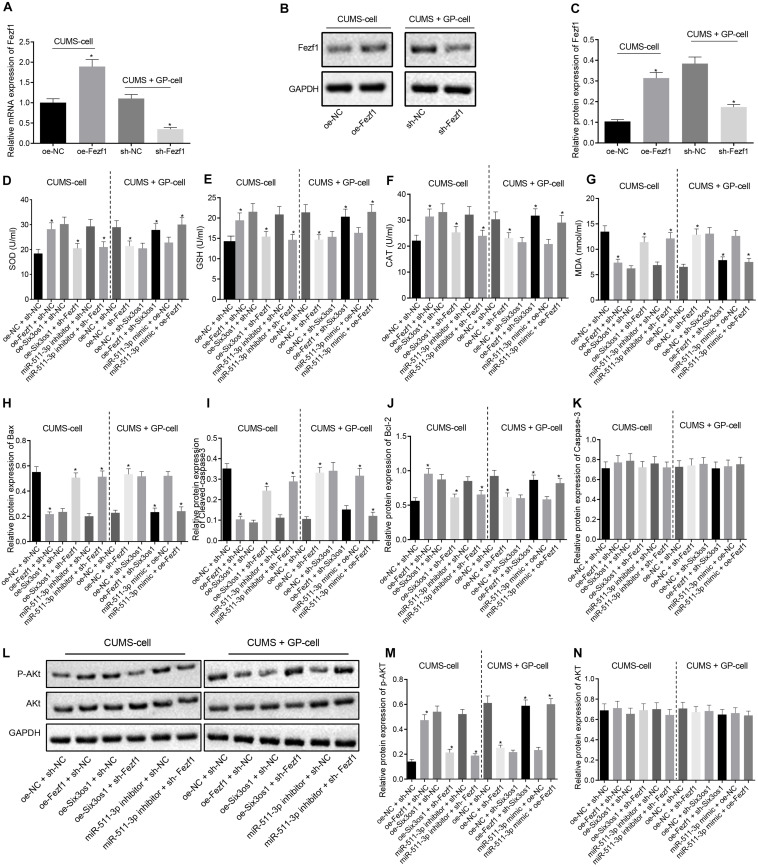
Six3os1 activates the Fezf1/AKT axis by binding to miR-511-3p, thus ameliorating oxidative stress of CUMS-induced neurons. (A) Fezf1 mRNA expression in neurons after alteration of Fezf1 detected by RT-qPCR. (B,C) Immunoblots (B) and quantitation (C) of Fezf1 protein expression normalized to GAPDH in neurons after alteration of Fezf1 examined by Western blot analysis. The CUMS-induced neurons were treated with oe-NC + sh-NC, oe-Fezf1 + sh-NC, oe-Six3os1 + sh-Fezf1, miR-511-3p inhibitor + sh-Fezf1, oe-Six3os1 + sh-NC or miR-511-3p inhibitor + sh-NC, and CUMS-induced neurons with GP treatment were infected with oe-NC + sh-NC, oe-NC + sh-Fezf1, oe-NC + sh-Six3os1, oe-Fezf1 + sh-Six3os1, miR-511-3p mimic + oe-NC or miR-511-3p mimic + oe-Fezf1. (D–G) SOD (D), GSH (E), CAT (F), and MDA (G) contents in neurons determined by ELISA. (H–K) Quantitation of Bax (H), Cleaved-caspase3 (I), Bcl-2 (J), and caspase3 (K) protein expression normalized to GAPDH in neurons detected by Western blot analysis. (L–N) Immunoblots (L) and quantitation of AKT expression (M) and p-AKT (N) normalized to GAPDH in neurons determined by Western blot analysis. The measurement data were presented as mean ± standard deviation. Data between two groups were compared by independent sample t-test, and data among multiple groups were analyzed by one-way ANOVA, followed by Tukey’s post hoc test. Cell experiments were repeated three times. ∗p < 0.05 vs. oe-NC + sh-NC, oe-Six3os1 + sh-NC, miR-511-3p inhibitor + sh-NC, oe-NC + sh-Six3os1 or miR-511-3p mimic + oe-NC.